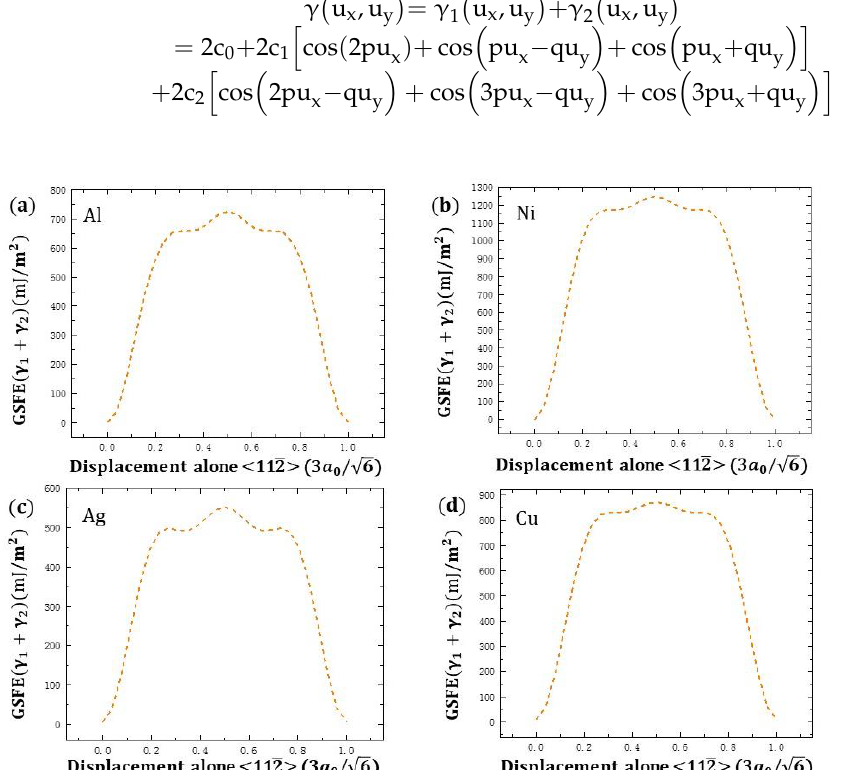
+ γ ) of fcc Al, Ni, Ag and Cu ob- 1 2 and 1